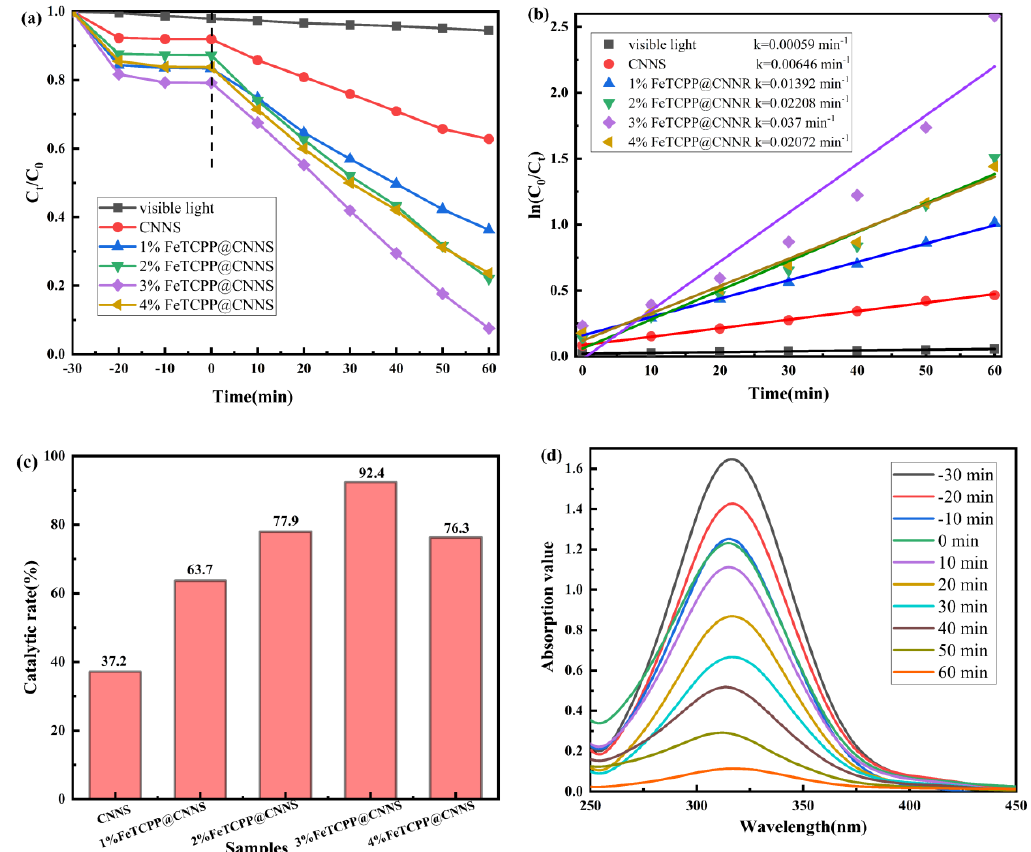
Figure 8. ( a ) Photocatalytic degradation for 4-NP aqueous solution over different